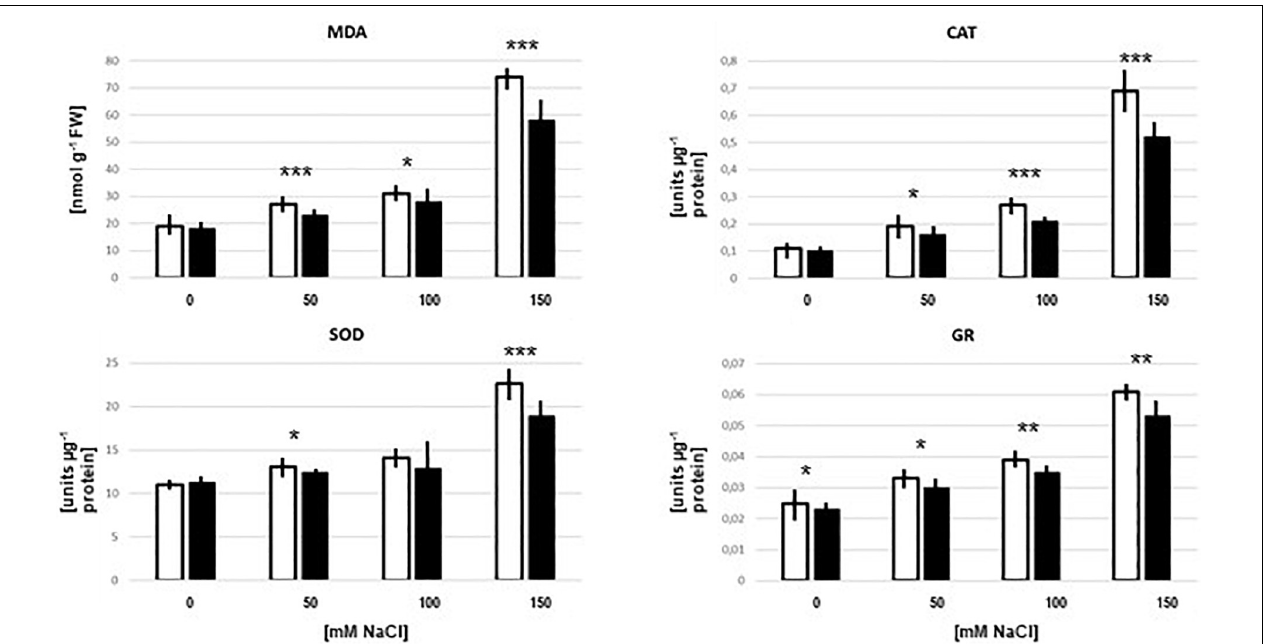
FIGURE 5 | MDA levels and CAT, SOD, and GR enzyme activities in the root of Arabidopsis seedlings which were either colonized (black bars) or mock-treated (white bars) with Trichoderma on media with 0–150 mM NaCl. The treatment was identical to that for the peptide extraction. The results are based on 3 independent experiments, bars represent SEs. Asterisks above the bar pairs indicate significant differences by Student’s t -test (* p < 0.05, ** p < 0.01, *** p <